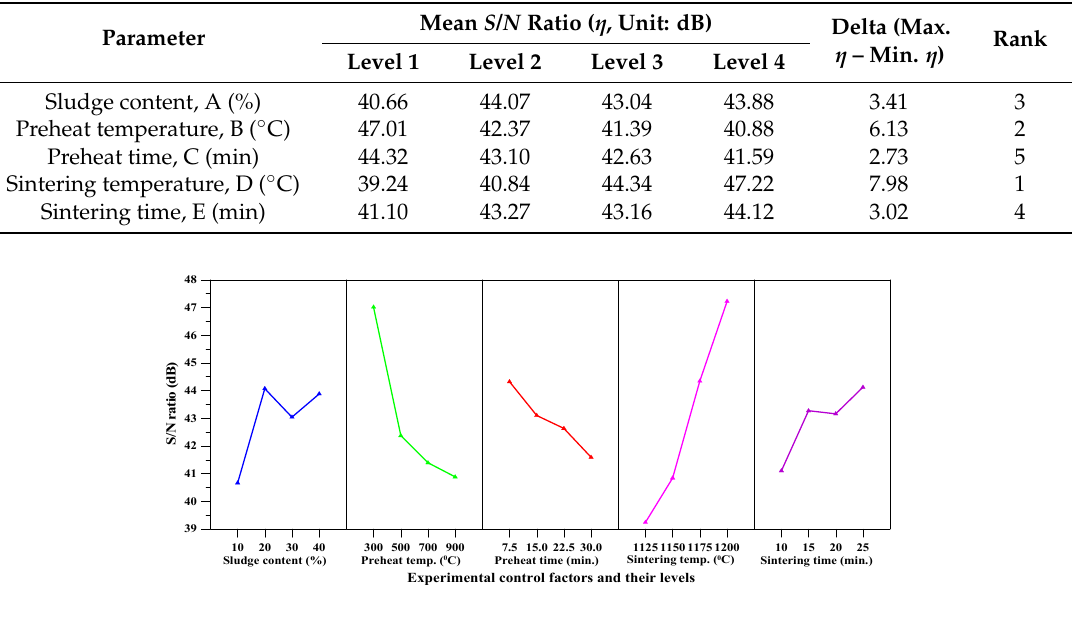
Table 11. Analysis of variance and F test for bloating